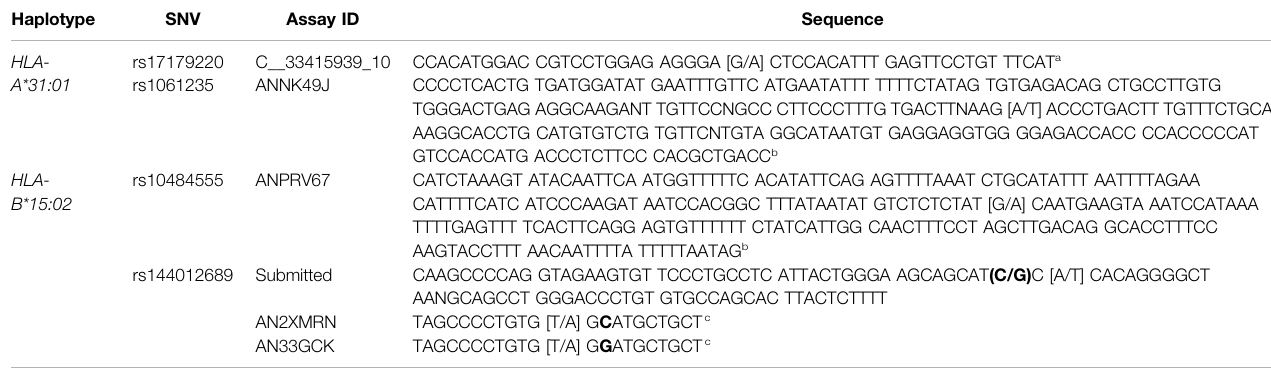
TABLE 3 | Sequences submitted for TaqMan SNP Genotyping